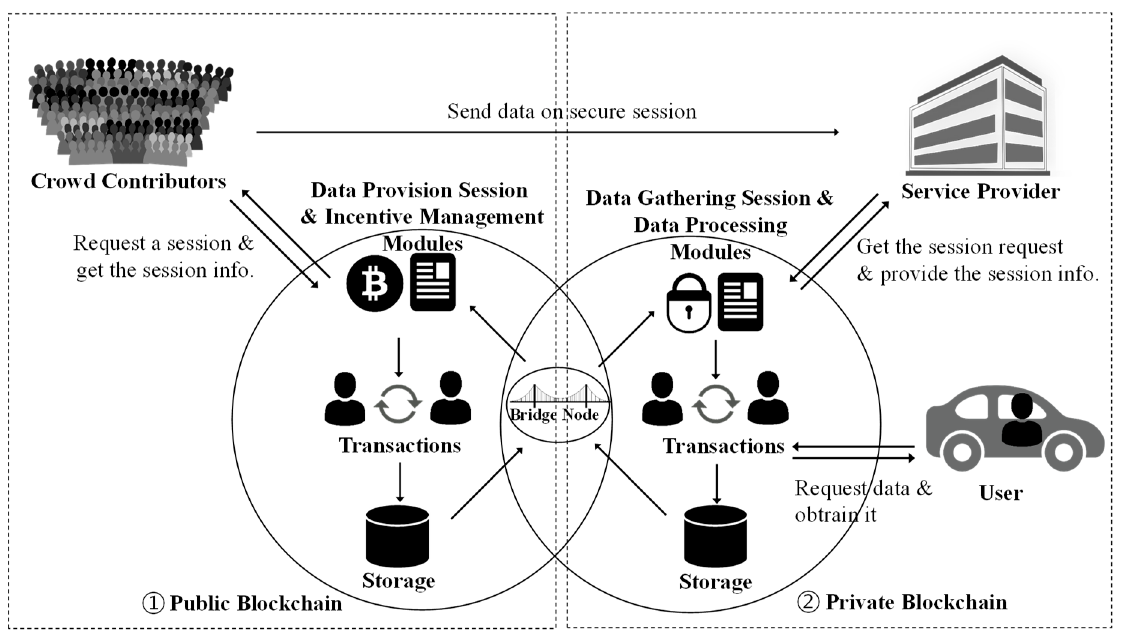
Figure 2. Structure of the proposed system.